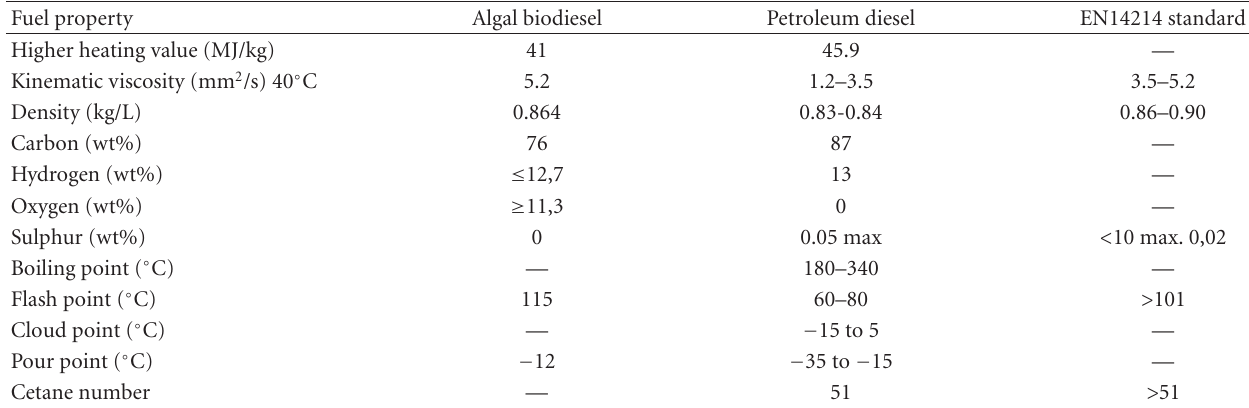
Table 3: Comparison of selected properties of algal biooil and typical conventional diesel with respect to the European norm for biodiesel [14].